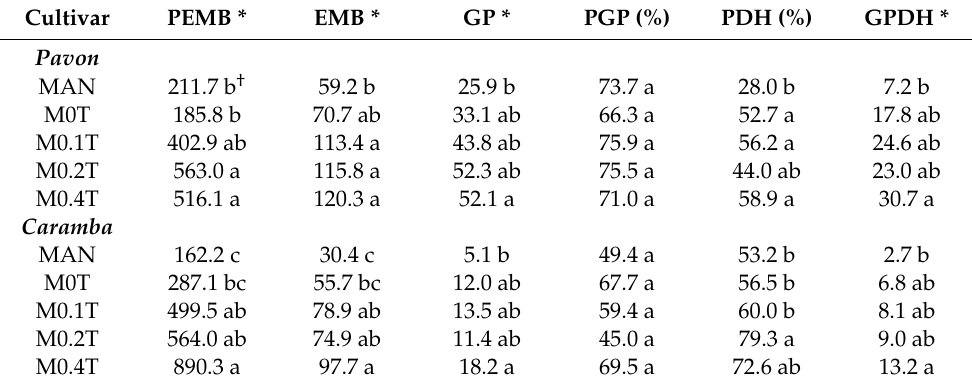
Table 2. Microspore embryogenesis of bread wheat cvs. Pavon and Caramba after the application of 0, 0.1, 0.2, and 0.4 µ M TSA simultaneously with mannitol stress treatment for 5 days at 25 ◦ C (M0T, M0.1T, M0.2T, and M0.4T) and MAN (control culture, 0.7M mannitol for 5 days at 25 ◦ C). Table shows